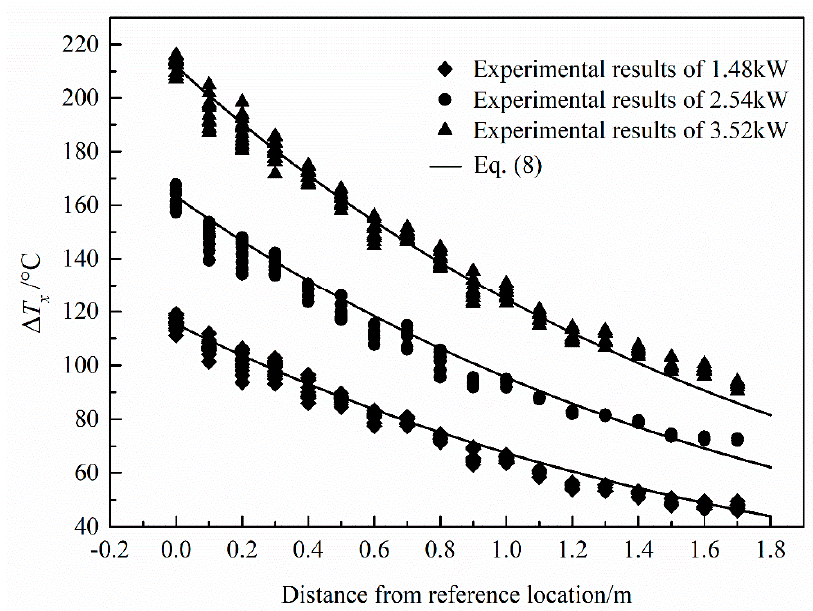
Figure 9. Comparisons of smoke temperature rise below the ceiling in the fire section between experimental results and results obtained from Equation (8).